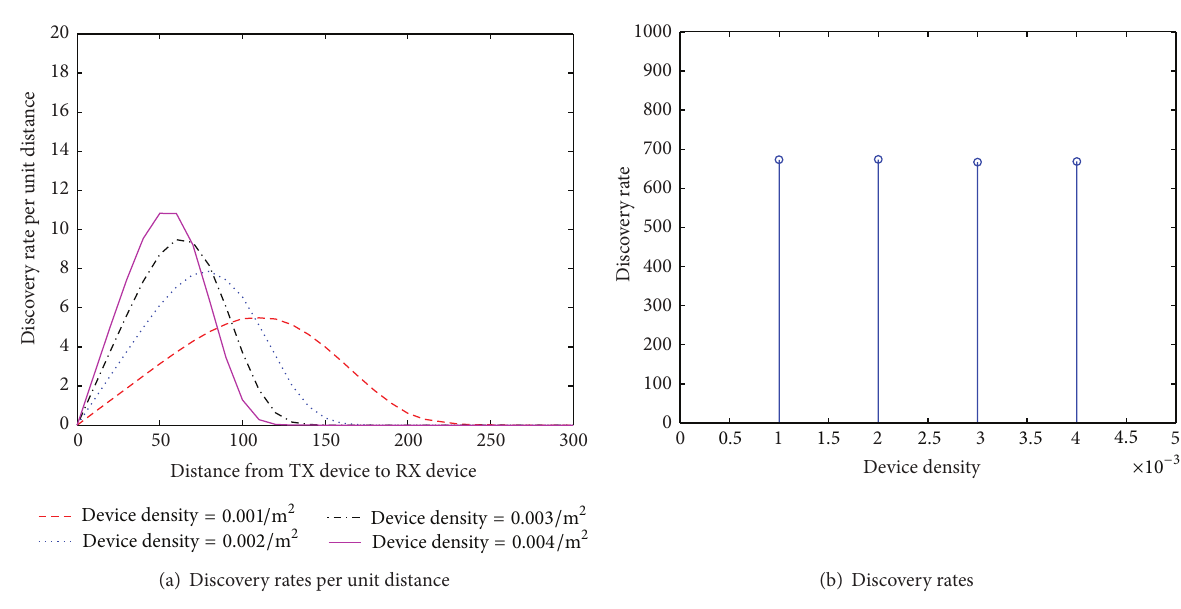
Figure 5: Discovery rates with varying sensing thresholds.